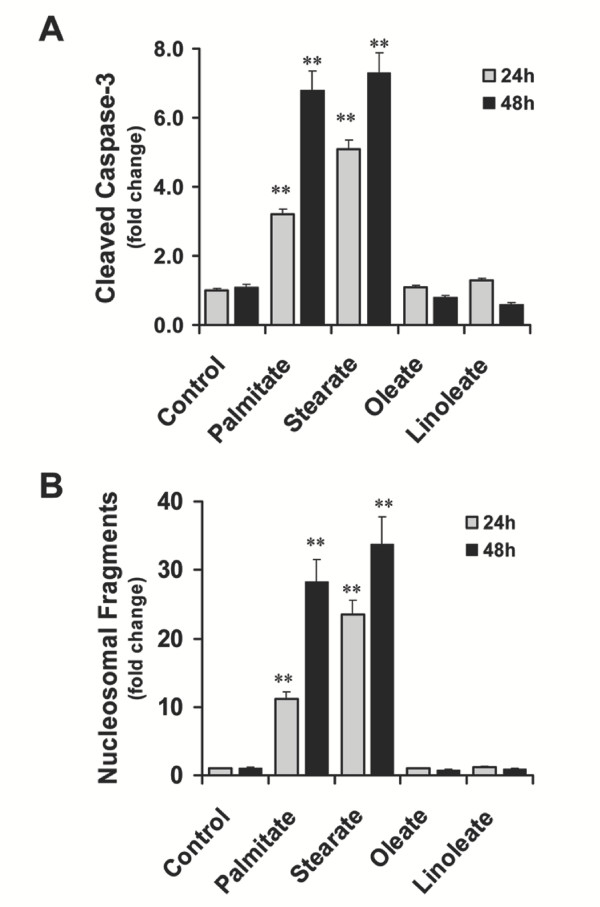
Saturated but not unsaturated FFA induce apoptosis in cultured HMC. HMC were plated for 24 h in media containing 17% FBS, then incubated starting at time 0 with the indicated FFA at 0.2 mM complexed to albumin or with albumin alone (Control), all in media containing 5% FBS. After 24 and 48 h, the level of (A) the cleaved fragment of caspase-3 and (B) cytoplasmic nucleosomal fragments were determined by ELISA and expressed relative to the 24 h control value. Data are mean ± SEM for n = 3 independent experiments in triplicate. **, P < 0.01 by ANOVA versus control, oleate, or linoleate alone.